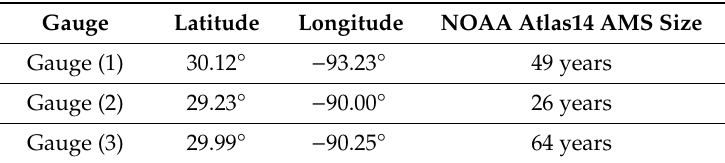
Table 1. The NOAA Atlas 14 gauges selected in our study to evaluate the spatial bootstrap approach when using radar-based precipitation